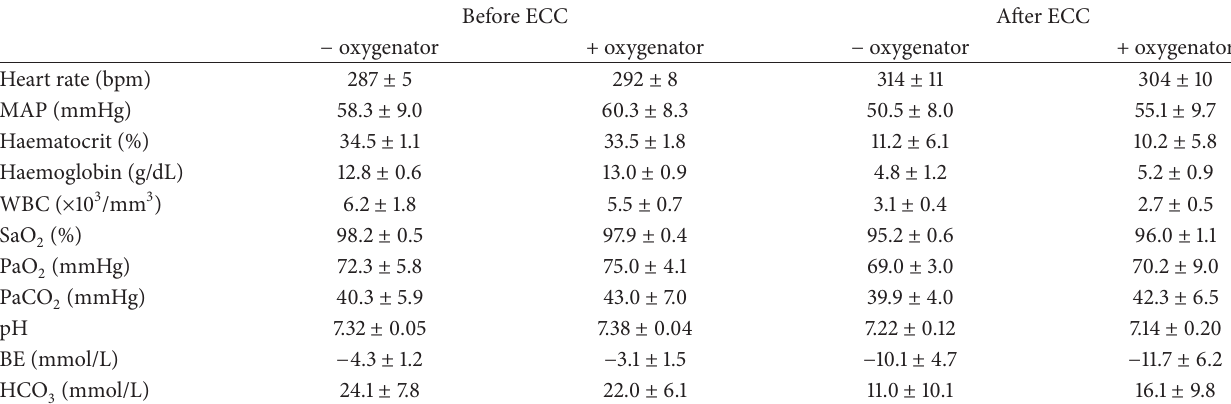
Table 1: Hemodynamic and physiological